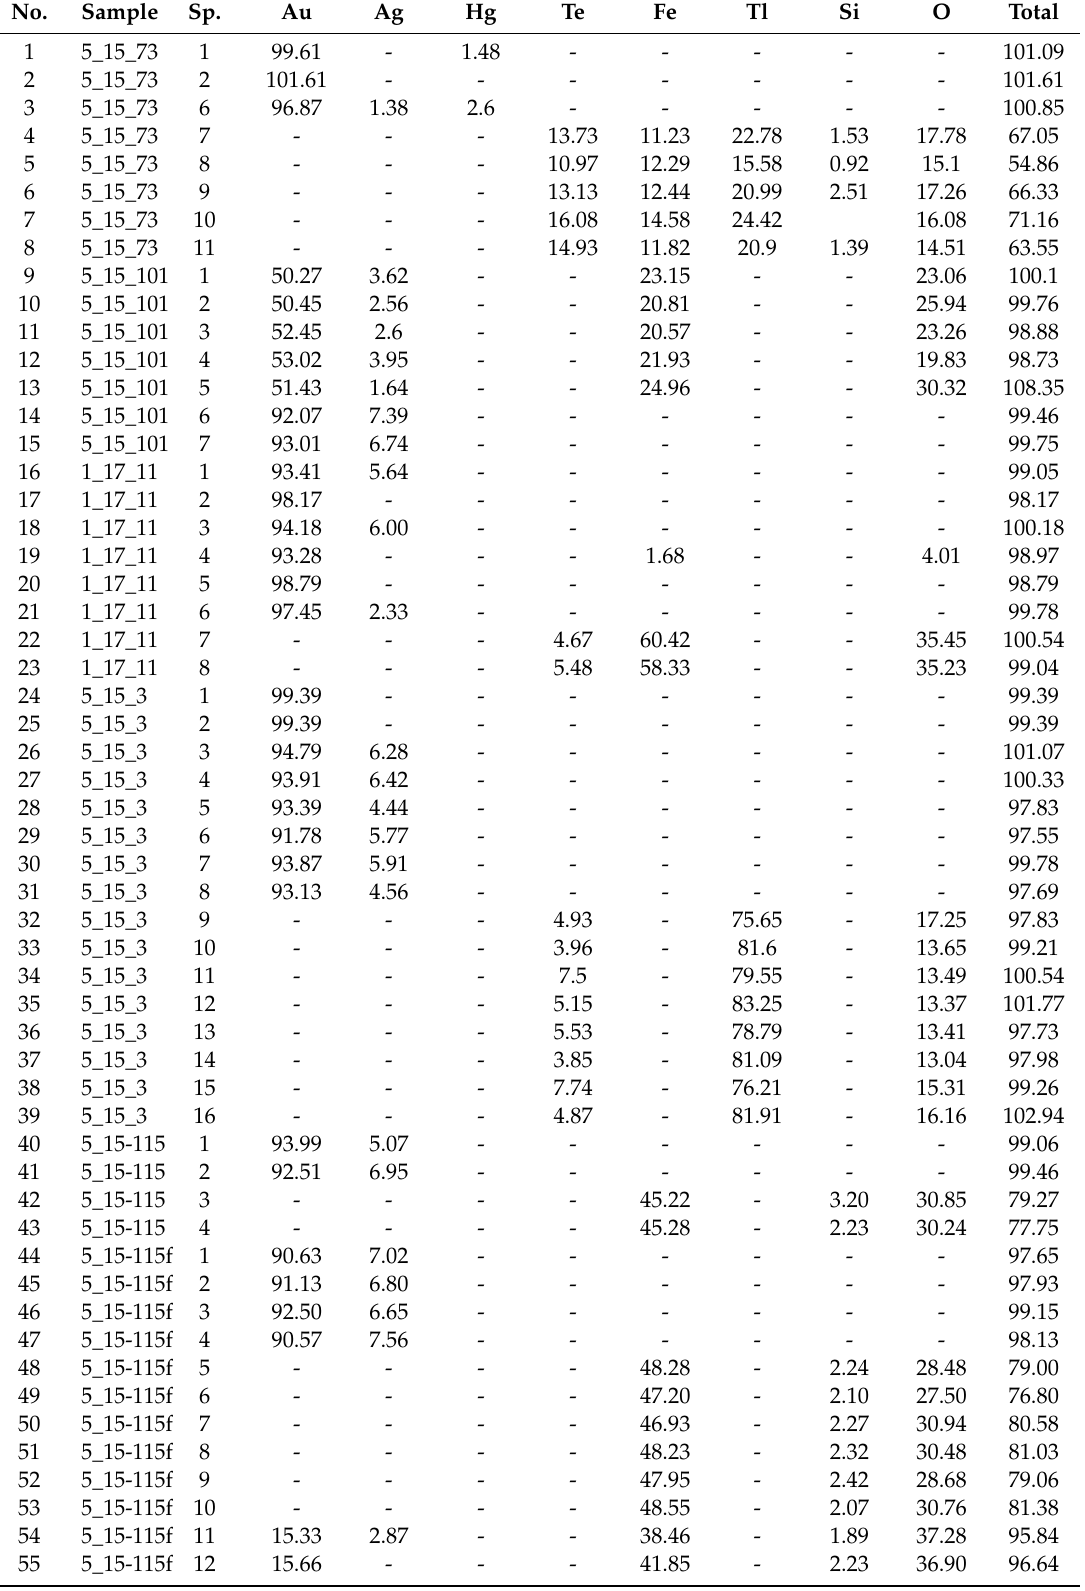
Table 3. The composition of the massive gold and associated minerals (in wt%) shown in Figures 5 and